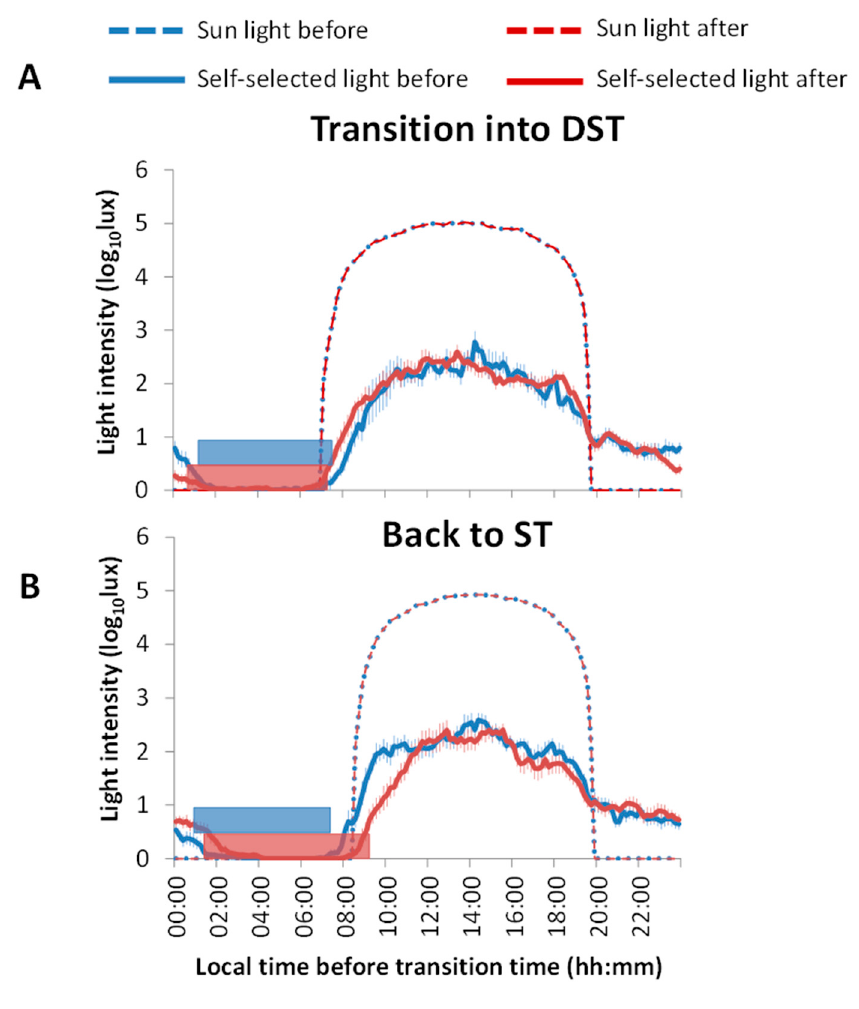
Figure 3. Mean 24-h waveforms of the participants’ ( n = 8) exposure to artificial light and sunlight (in log lux units) in the same period and location before and after transitions to DST ( A ) and back to ST ( B ). Blue lines indicate the participants’ light exposure before the time change, and red lines show it after the time change. Dotted lines represent the intensity of the sunlight, and horizontal bars show the average sleep period ( n = 8) before (blue) and after (red) the transitions. Data are expressed as the mean ± SEM.